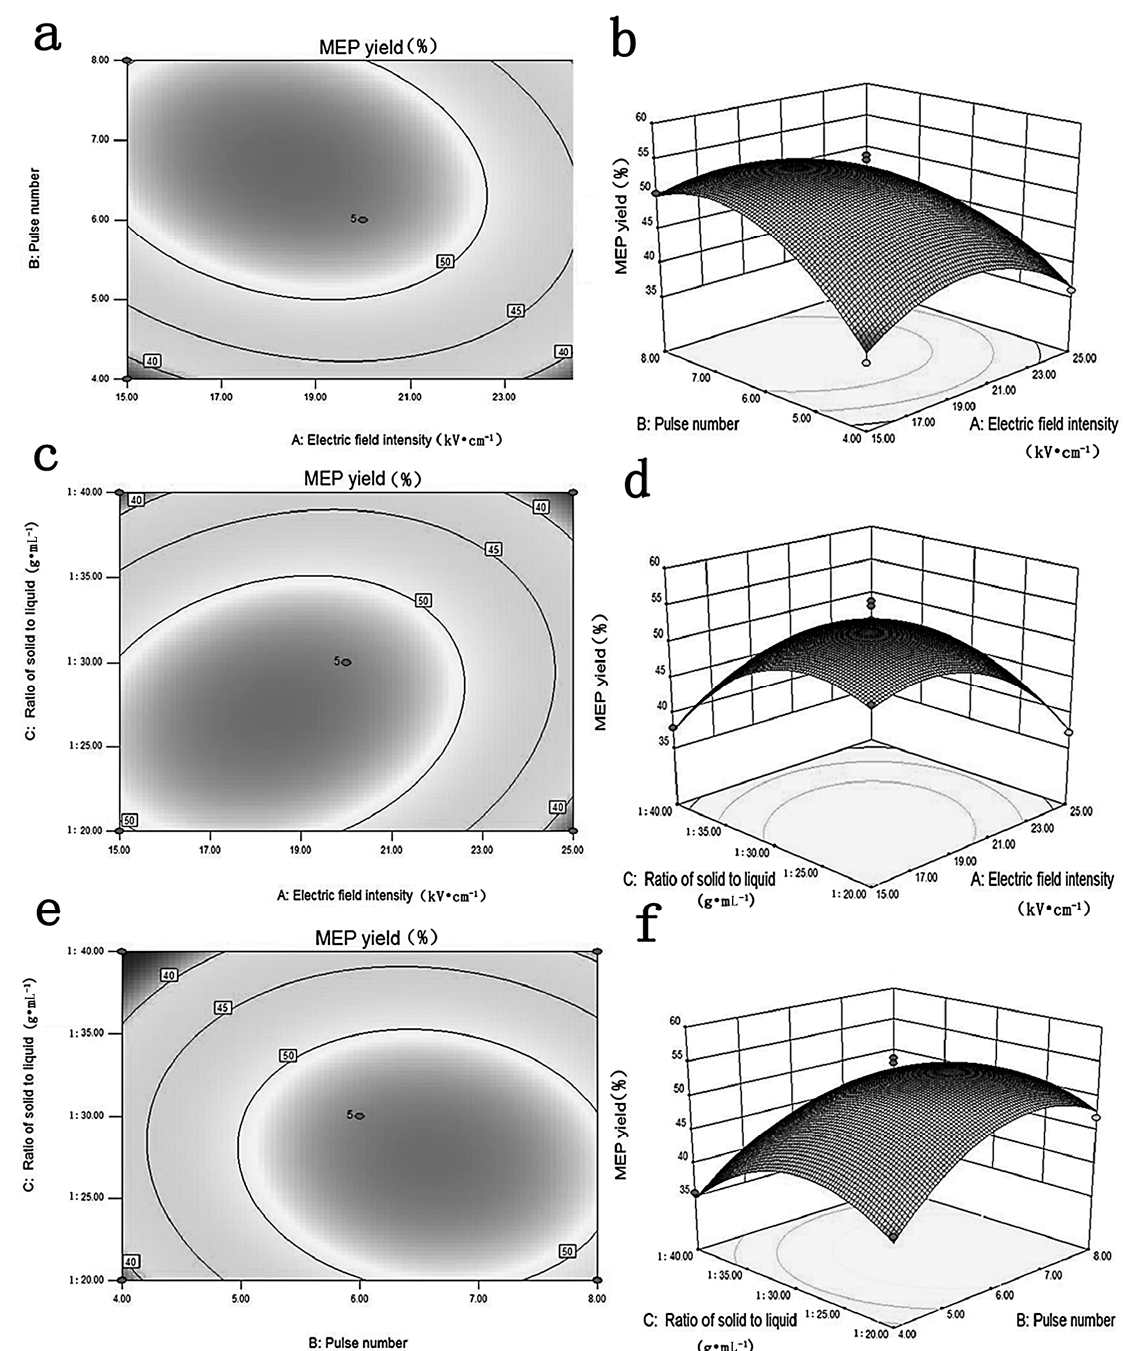
Figure 1. The effects of electric field intensity (X 1 ), pulse number (X 2 ) and material-to-liquid ratio (X 3 ) on M. esculenta polysaccharide (MEP) yield of 3D response surface curves ( a , c , e ) and contours ( b , d , f ).